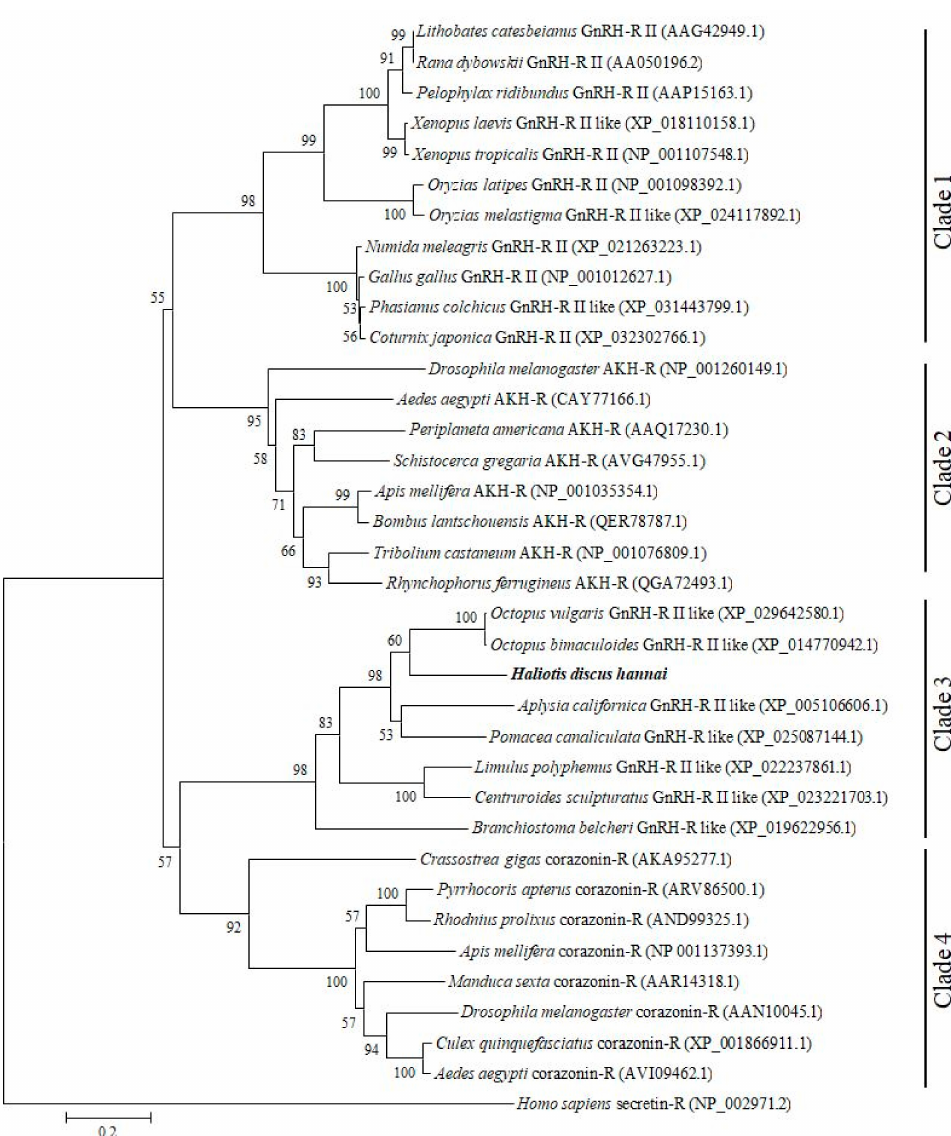
Figure 3. Molecular phylogenetic tree of GnRH-R and other related proteins from vertebrates and invertebrates. A phylogenetic tree was constructed from the amino acid sequences using the maximum likelihood method. Bootstrap probabilities are given at each node. The scale bar indicates an evolutionary distance of 0.2 amino acid substitutions per site. The GnRH-R gene of H. discus hannai is highlighted in bold font. H. sapiens secretin receptor was used as